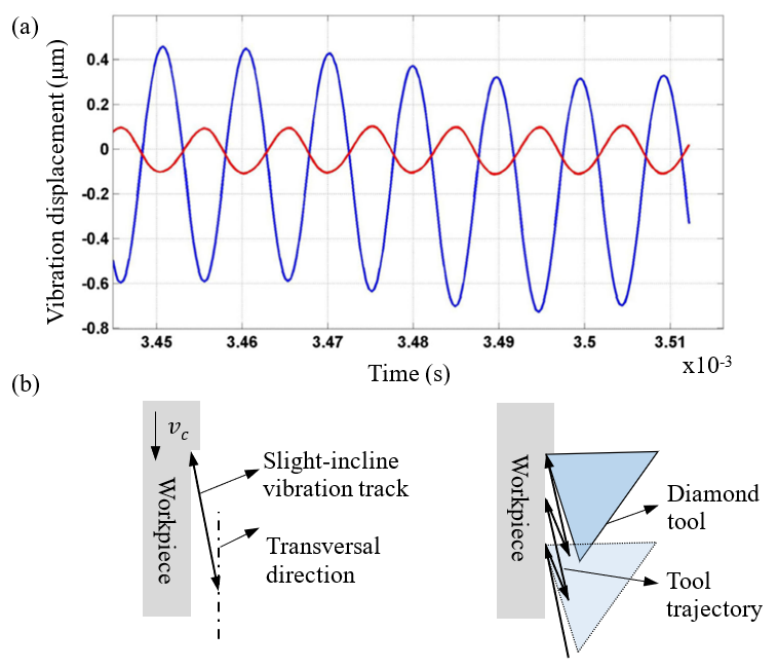
Figure 3. ( a ) Diamond tool tip transversal vibration displacement (blue line) and longitudinal vibration displacement (red line) during the cutting stage [19]. ( b ) Schematic of the tool tip movement of the slight-incline UVAC.